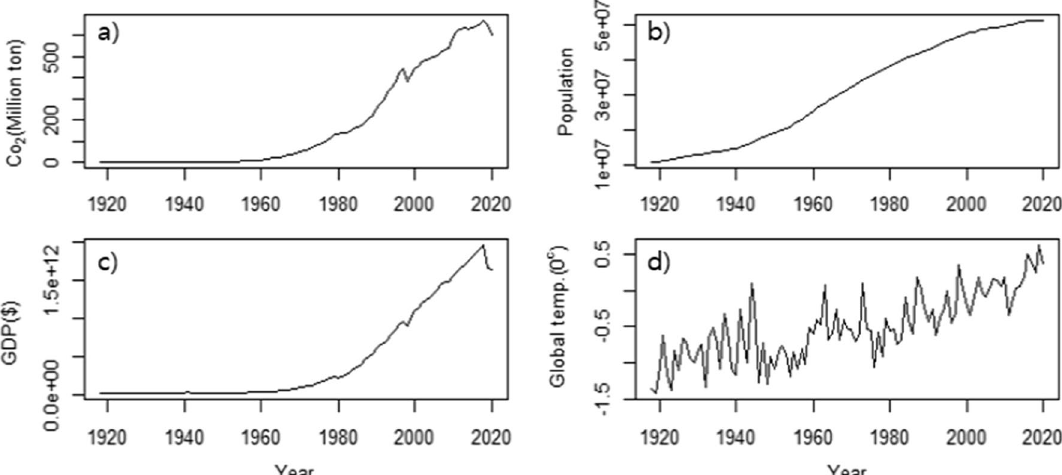
Fig. 2 Time‑series data about a CO 2 (in millions of tons); b population (Pop); c GDP (USD) of South Korea; and d global surface temperature anomalies (GTemp) from 1918 to